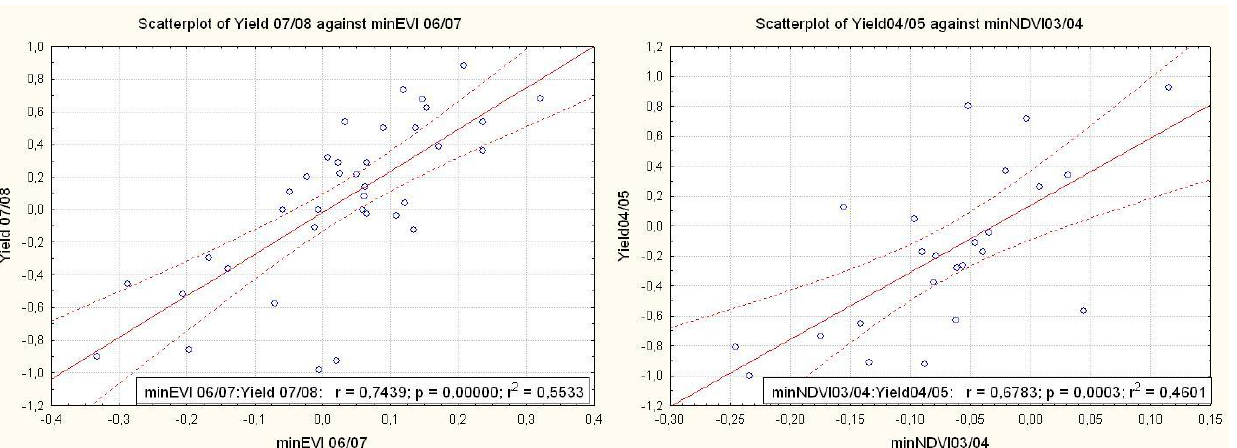
Figure 7. Correlation between variation on minimum values of vegetation indices (minEVI and minNDVI) and variation on coffee yield the following